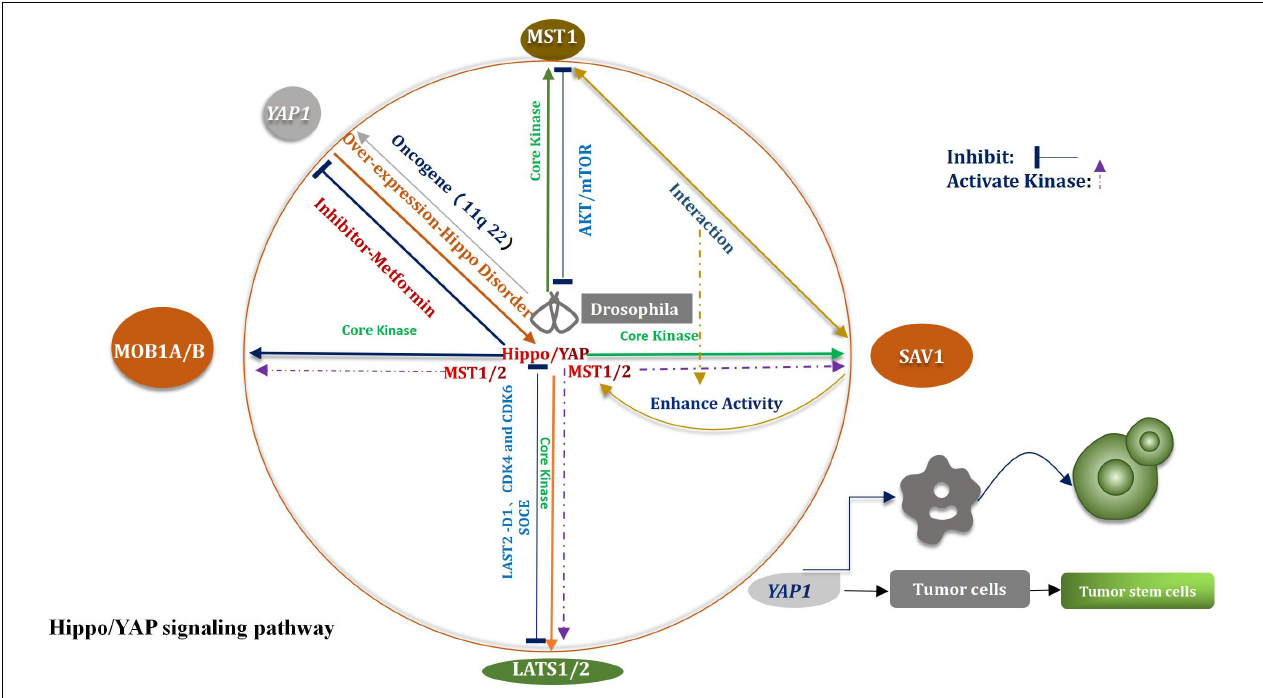
FIGURE 1 | Hippo/YAP signal